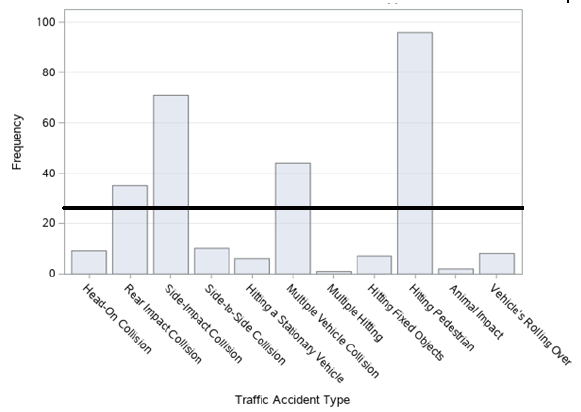
Figure 9. Bar graph of traffic accidents on Halaskargazi Street in Şişli district by accident type.